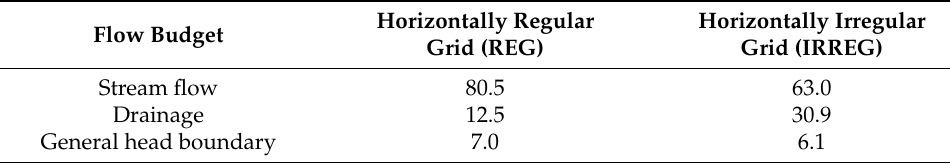
Table 2. Flow balance distribution relative to the total outflow in